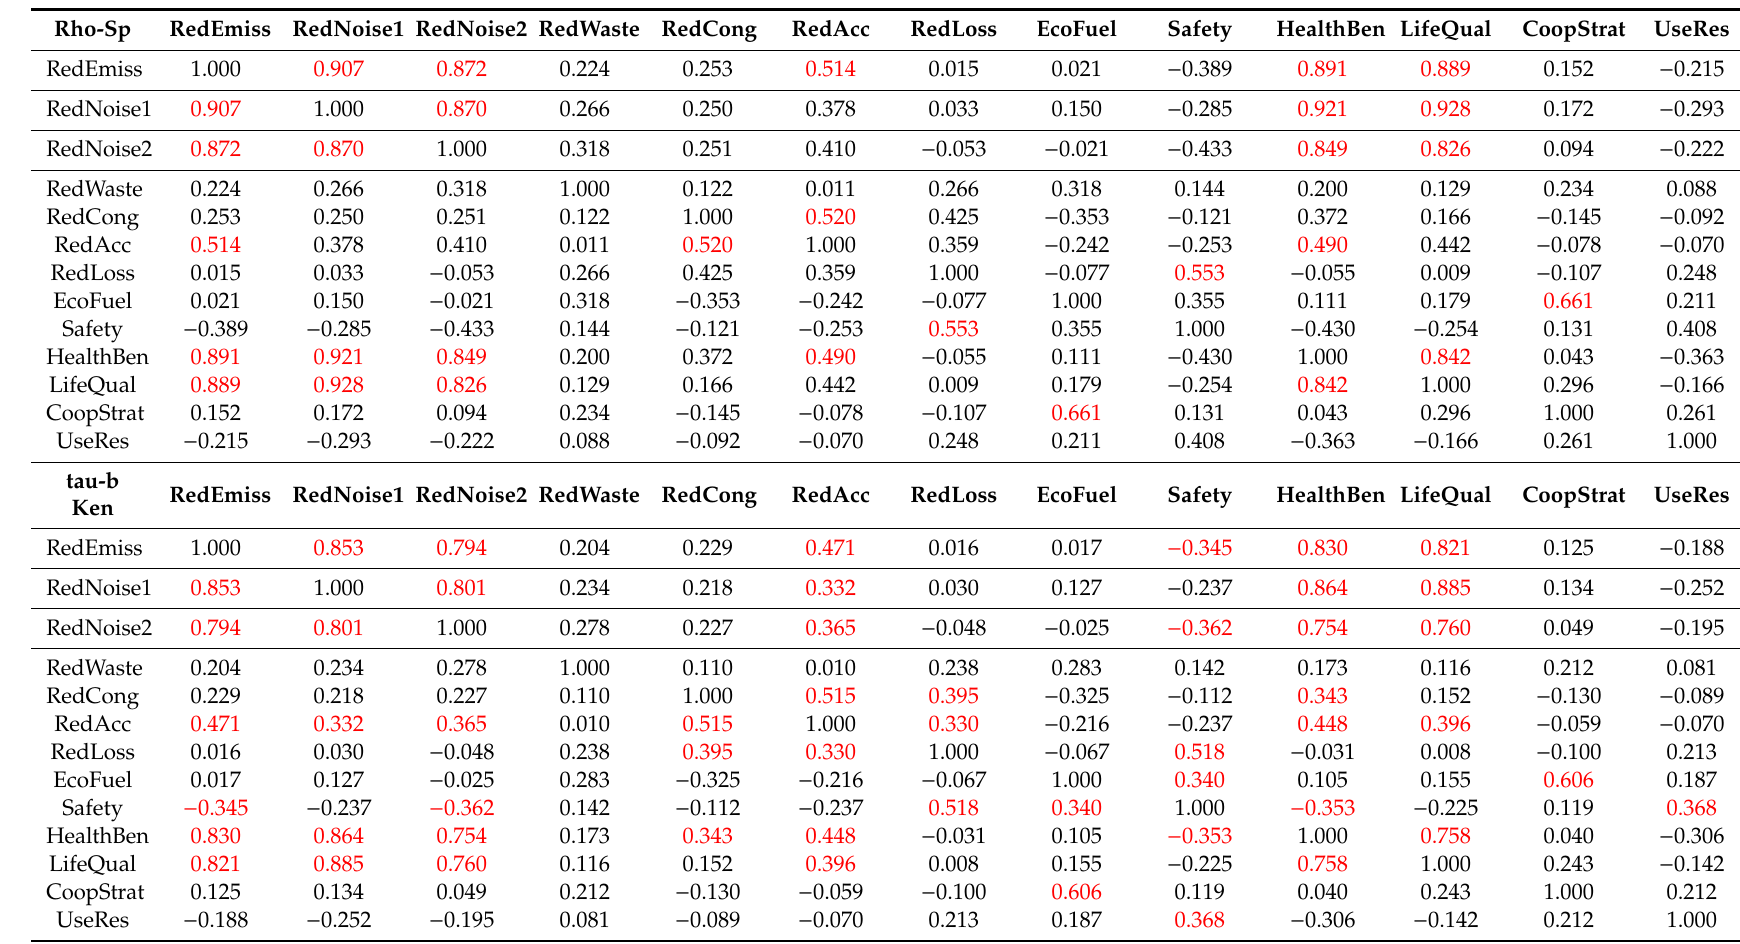
Table 6. Results of rho-Spearman and tau-Kendall calculations